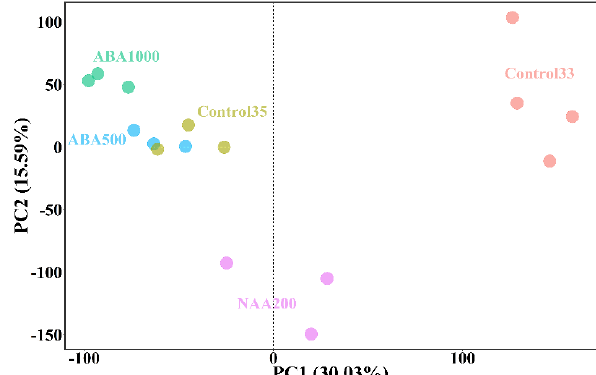
Figure 2. Principal component analysis of the ABA-treated, NAA-treated, and control groups. Variables are the transcript abundance of 27,267 genes. Each circle represents a biological replicate.